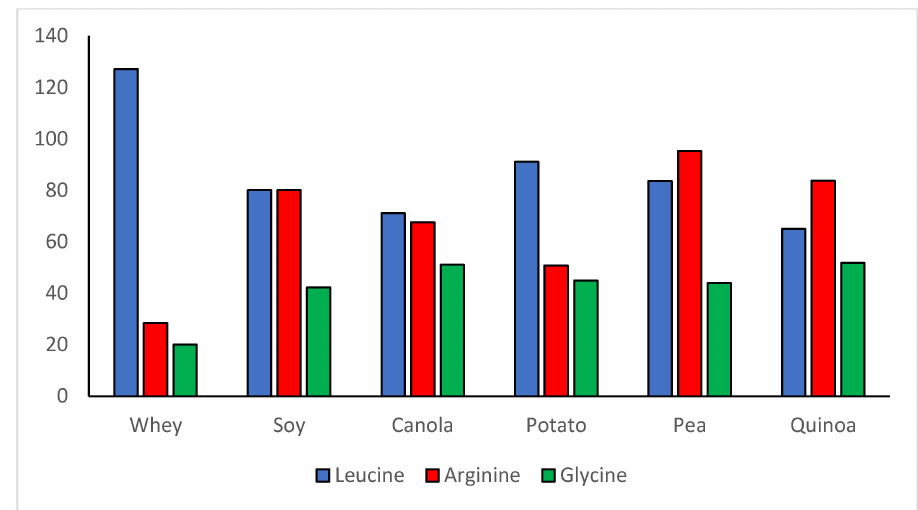
Figure 2. Comparisons of leucine and selected dispensable amino acid concentrations (mg / g protein): whey versus the Top 5 highest quality plant proteins in Table 2. Glutamine concentration of selected plant and dairy